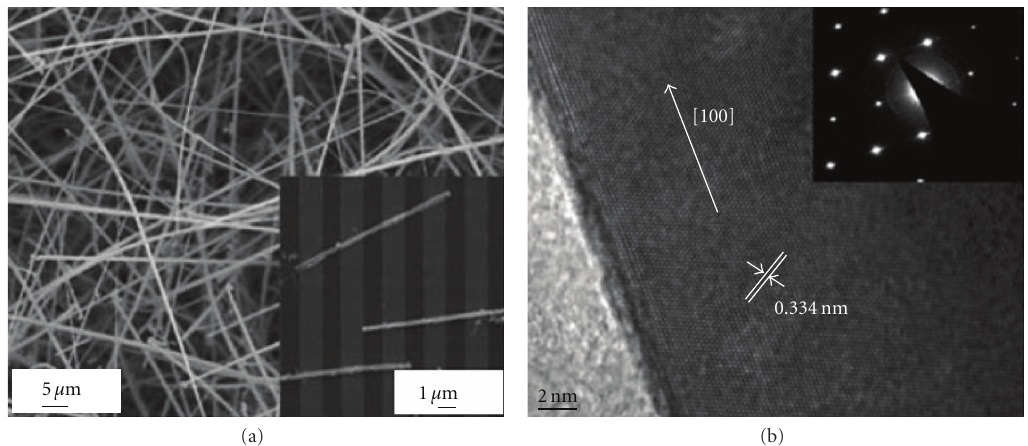
Figure 1: SEM image and of high-resolution TEM image with the corresponding SAED pattern of SnO 2 nanowires.